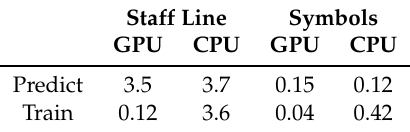
Table 10. Prediction and training times in seconds. For the staff line detection the numbers denote the time to process a whole page, while for the symbol detection the reference is a single staff. Prediction includes pre- and postprocessing; however, training only refers to a single